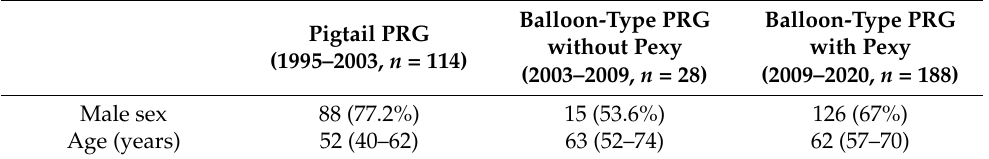
Table 1. Sex and age distribution of patients undergoing PRG at the Hospital Universitario Virgen del Roc í o between 1995 and